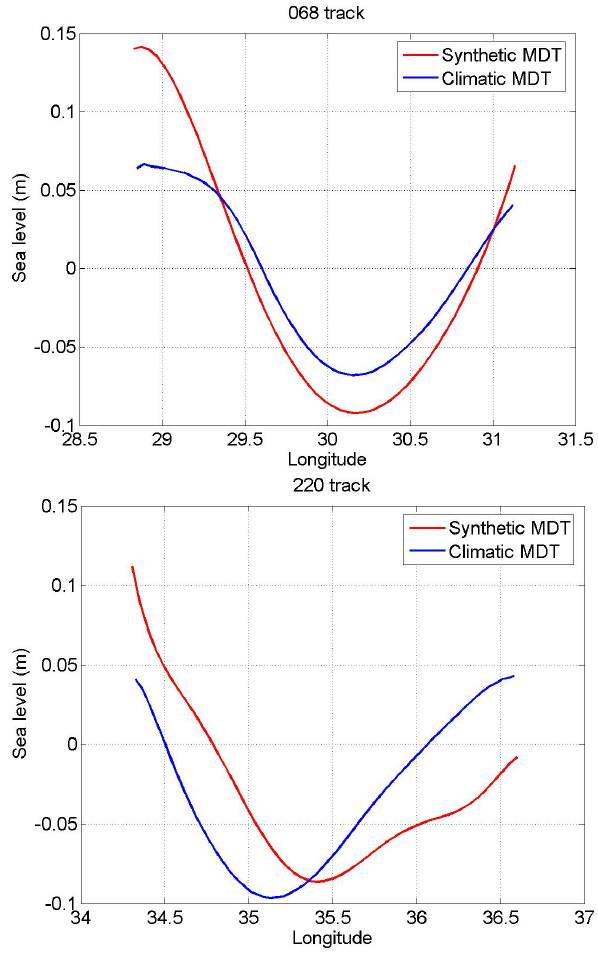
Fig. 4. Synthetic MDT computed in Black Sea along tracks No. 68 and No. 220 of Topex/Poseidon from drifters measurements and SLA and, for comparison, climatic MDT along the same tracks.